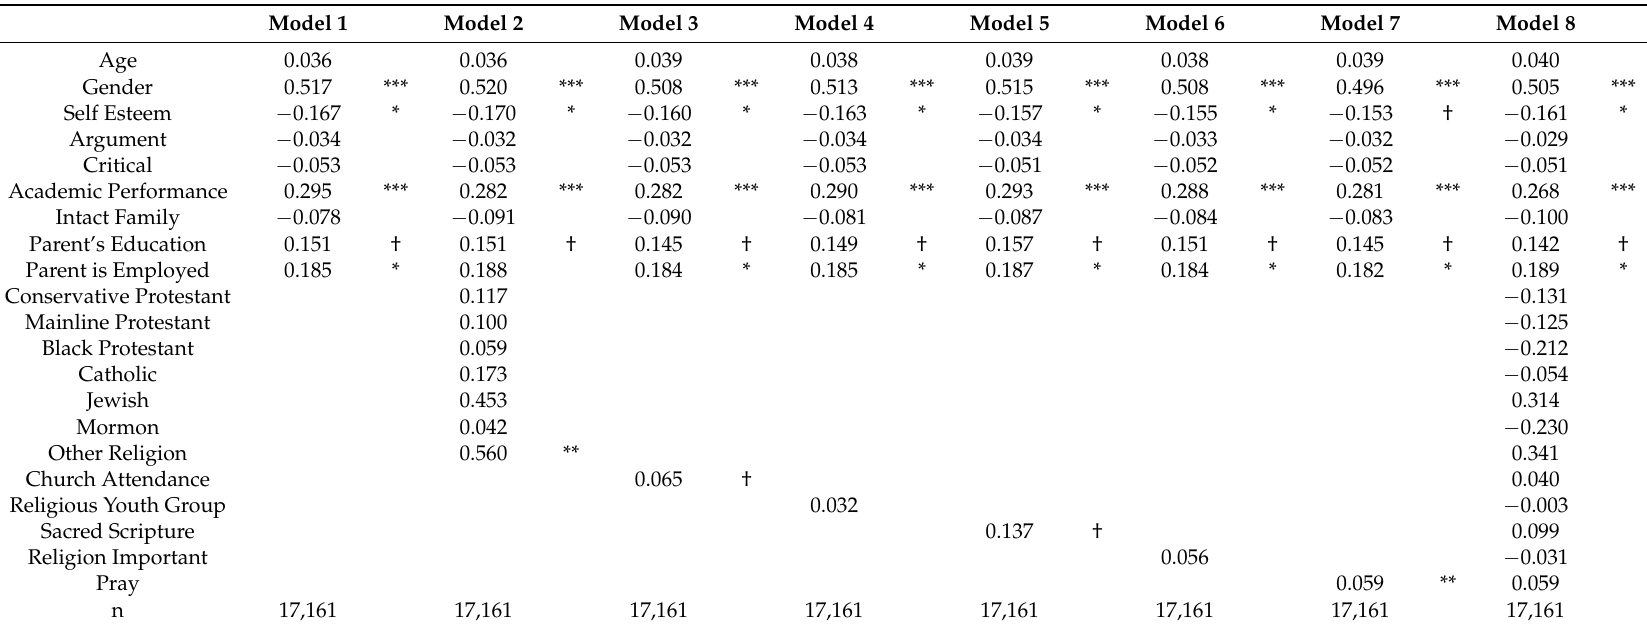
Table 4. Logistic Regression to Predict Patience and Attentiveness.